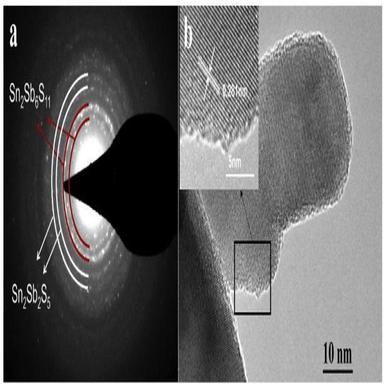
a) SAED pattern and b) HRTEM image of yolk-shell Sn-Sb-S microflower composite.